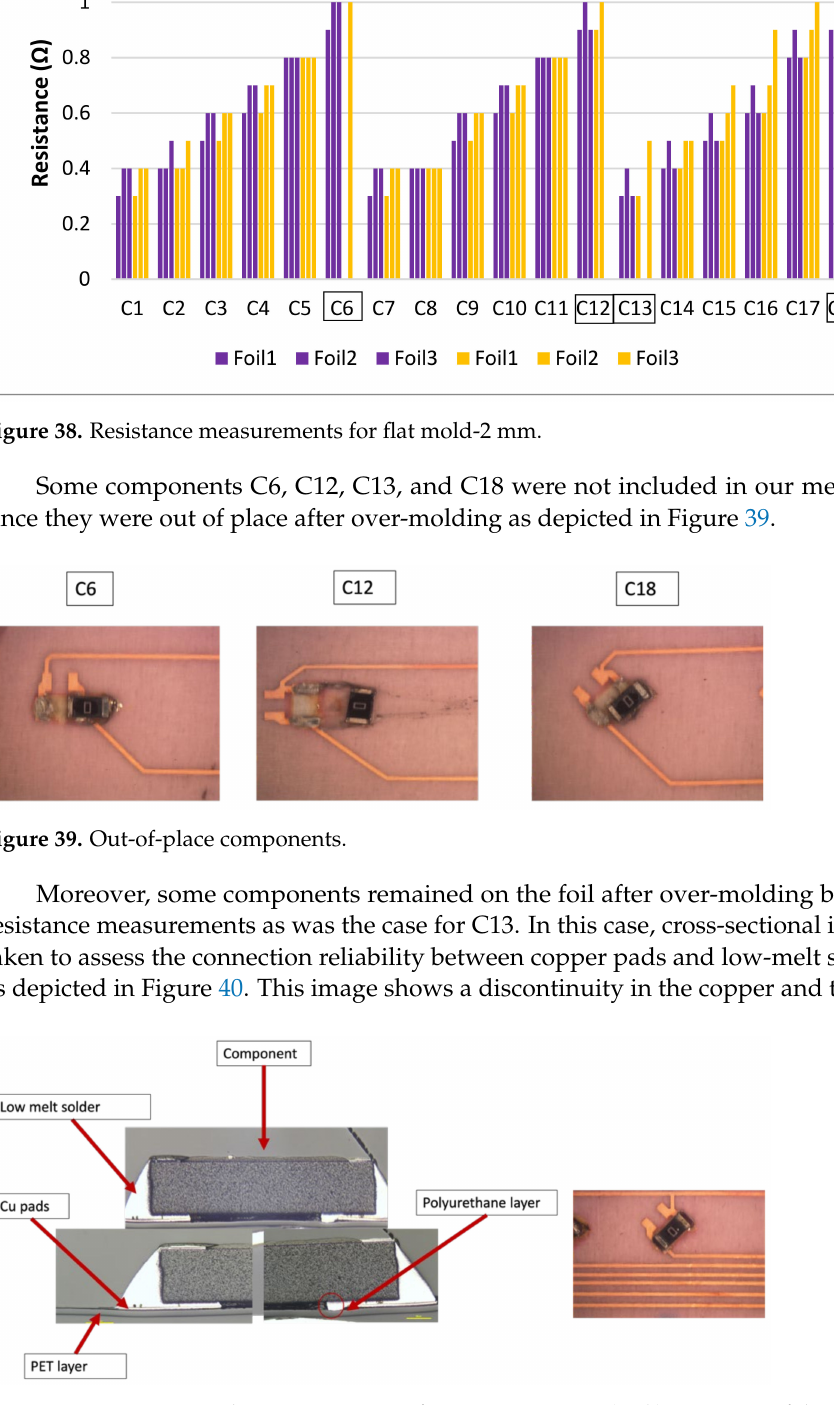
Figure 40. Cross-sectional images at 500 µ m for component C13 ( Left ). Top view of the component at 2000 µ m ( Right